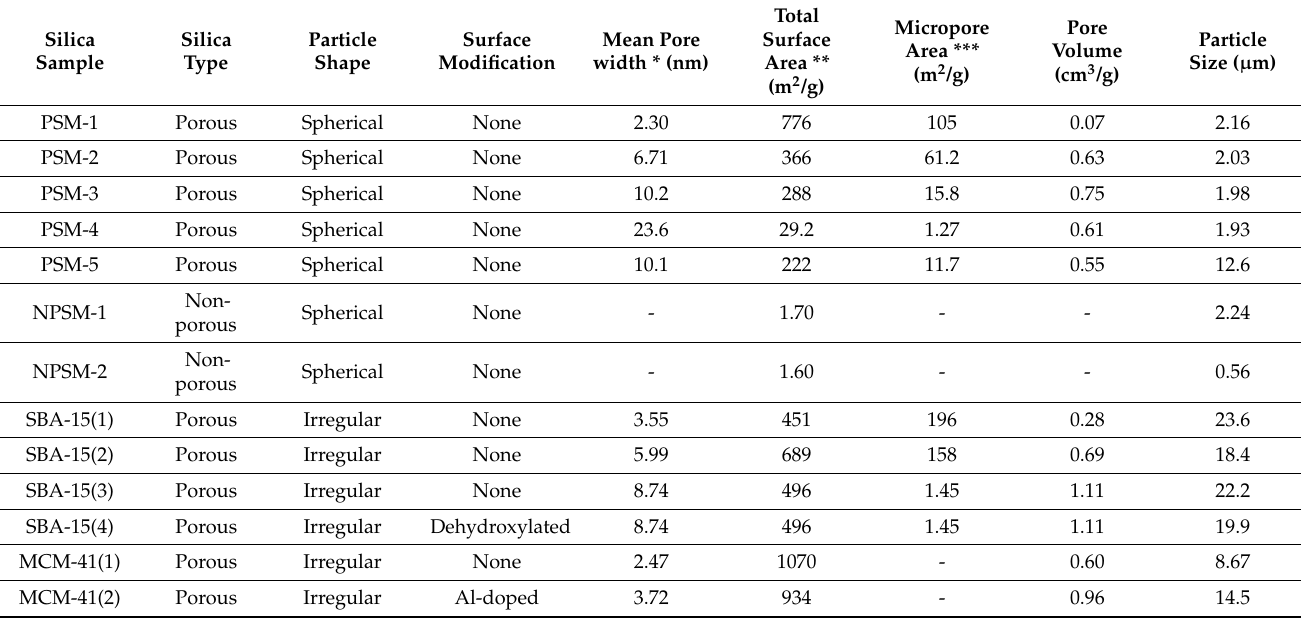
Table 1. Medium-chain triglycerides (MCT; Miglyol 812 ® ) were obtained from Hamilton Laboratories (Adelaide, Australia). FaSSIF/FeSSIF/FaSSGF powder for lipolysis studies was purchased from Biorelevant.com Ltd. (London, UK). Lipase from Candida antarctica (6000 TBU/mL), starch (soluble), cellulose, sodium hydroxide pellets, glacial acetic acid, sodium chloride, 4-bromophenylboronic acid (4-BBA), deuterated chloroform (CDCl 3 ), and phosphate buffered saline (PBS) tablets were supplied by Sigma-Aldrich (Castle-Hill, Australia). Porcine pancreatin extract (activity equivalent to 8 × USP specification) was supplied by MP Biomedicals (Seven Hills, Australia). All chemicals and solvents were of analytical grade and used as received. High-purity Milli-Q water was used throughout the study. Table 1. Physicochemical properties of silica samples used in this